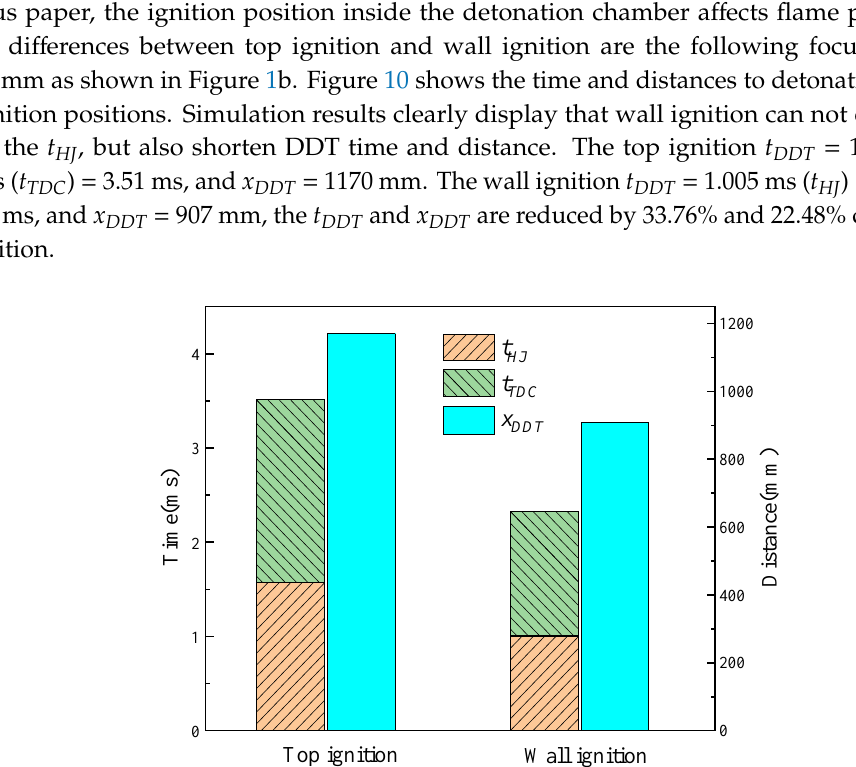
Figure 10. Time and distance to detonation initiation of top and wall ignition.